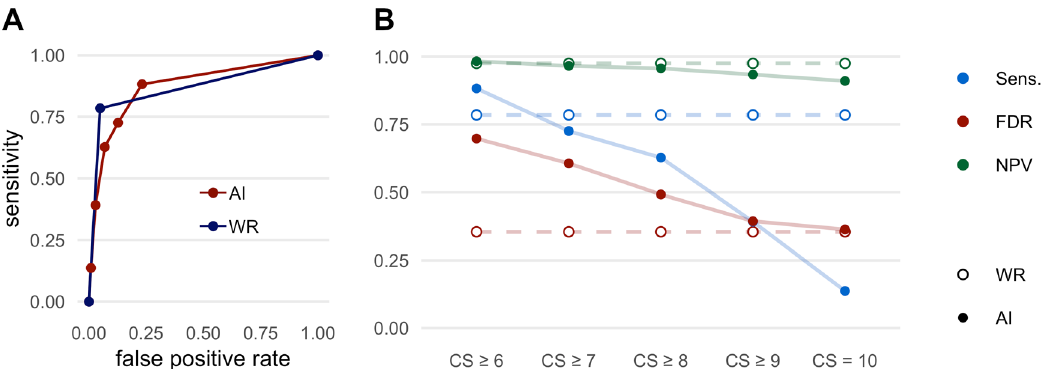
Figure 3. Performance metrics for the detection of consolidations. ( A ) Receiver operating characteristic (ROC) curves displaying the performance of the AI Rad Companion Chest X-ray (AI) and the radiologists (WR = written report) for the detection of consolidations (area under the curve (AUC) AI = 0.873/WR = 0.868). ( B ) Sensitivity (Sens.), negative predictive value (NPV) and false discovery rate (FDR) of the AI Rad Companion Chest X-ray (AI) and the radiologists (WR = written report) for the detection of consolidations. The sensitivity of the AI is slightly higher at a (confidence score =) CS ≥ 6; at the same time, the FDR is markedly higher. At CS = 10, the FDR is comparable to the WR, but the sensitivity is much lower. The NPV of the AI is high at all CS.